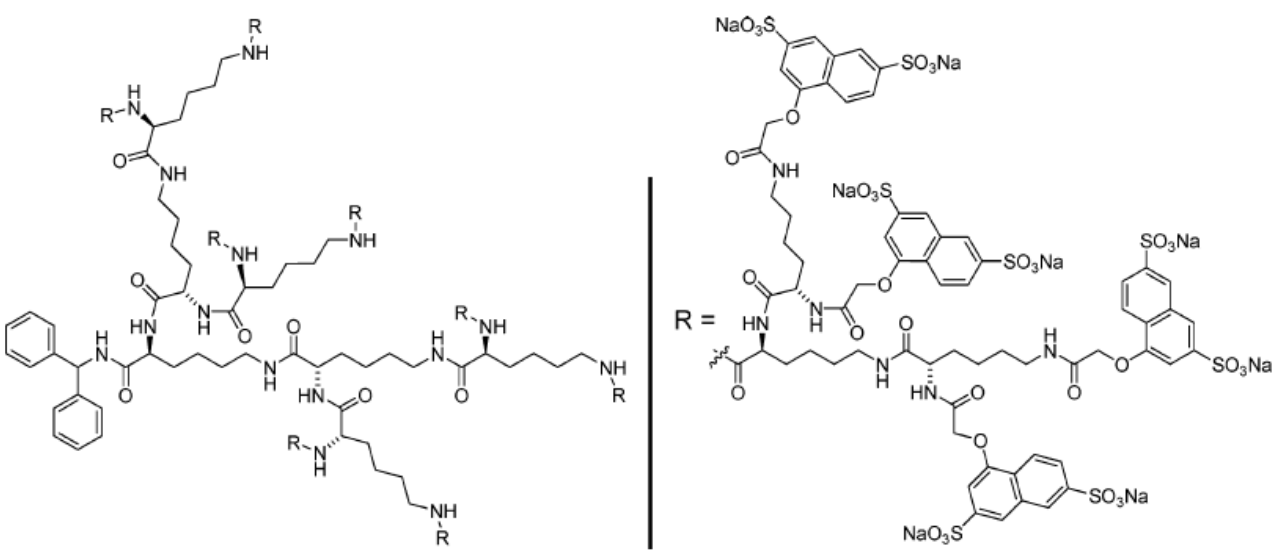
Figure 6. Starpharma’s SPL7013, also known as astodrimer sodium, a 4th generation p( L -Lys) dendrimer with an anionic surface charge. This product shows promise in the treatment of coronavirus disease, reproduced with permission from McCarthy et al. [68].